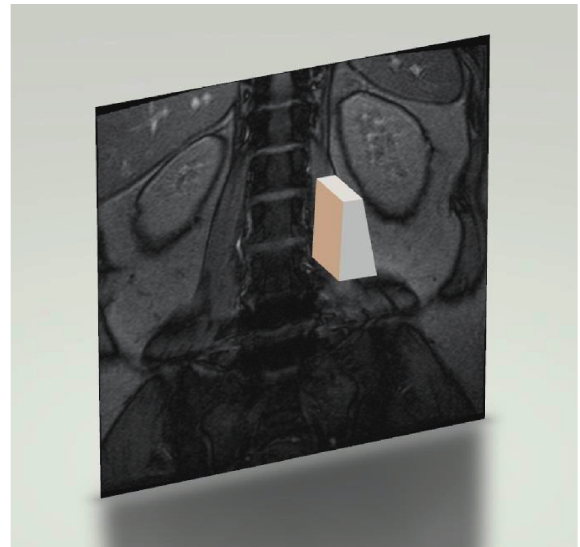
Figure 2: To estimate the volume, the entire ES muscle is considered as a circular table. The areas of the upper and lower segments are A and B, respectively. Using the height h between the upper and lower segments, the volume of the ES is estimated using the formula 􏽰 ���� V � ( 1/3 ) h ( S ) + S + S S A B A B